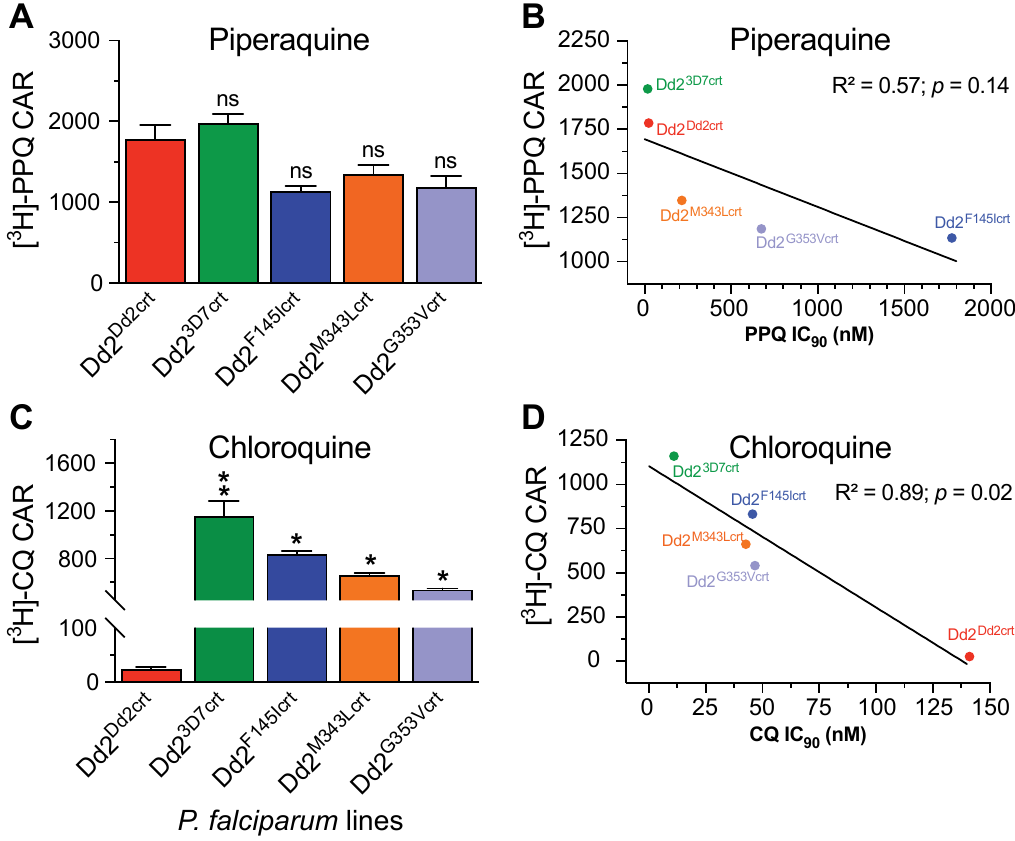
Fig 1. P . falciparum mutant PfCRT-mediated resistance to piperaquine (PPQ), unlike the related 4-aminoquinoline chloroquine (CQ), cannot be explained solely by reduced intracellular drug accumulation. Cellular accumulation ratios (CAR) represent the ratio of intracellular to extracellular (A) [ 3 H]-PPQ and (C ) [ 3 H]-CQ and were measured after 1hr incubation at 37˚C. Results were plotted against (B) PPQ and (D) CQ in vitro antiplasmodial activities as indexed by their 90% growth inhibitory concentrations (IC 90 ). Assays employed synchronized trophozoites, when the DV is fully formed and Hb degradation is maximal. CAR, IC 50 and IC 90 results for each line are presented as the mean ± SEM value (4 to 5 independent experiments with technical duplicates; see S1 Table and raw data in S1 Data ). Statistical significance was determined using Mann–Whitney U tests comparing the pfcrt -edited lines with their isogenic Dd2 Dd2crt parent. � p < 0.05; �� p < 0.01; ns; not